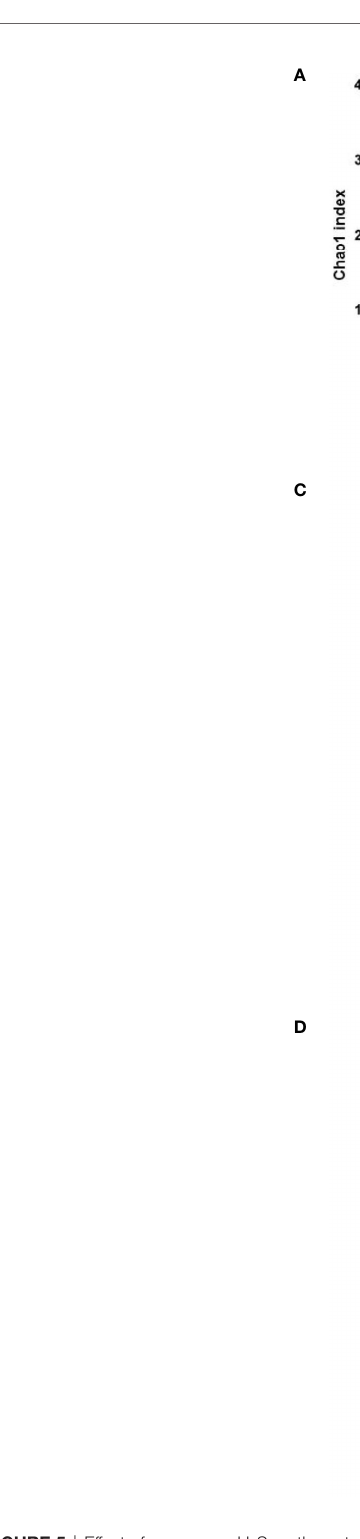
FIGURE 5 | Effect of exogenous H 2 S on the gut mycobiome structure. (A) Chao1 index. (B) Shannon index. (C) Unweighted UniFrac distance-based principal coordinate analysis (PCoA). (D) Weighted UniFrac distance-based PCoA. WT, wild-type mouse group (n = 6); DB, db/db mouse group (n = 6); DB-H 2 S, db/db mouse treated with NaHS group (n = 6). Data are shown as mean ± SEM. Differences were analyzed by the Kruskal – Wallis test with Dunn ’ s multiple-comparison test and denoted as follows: * p < 0.05, ** p <